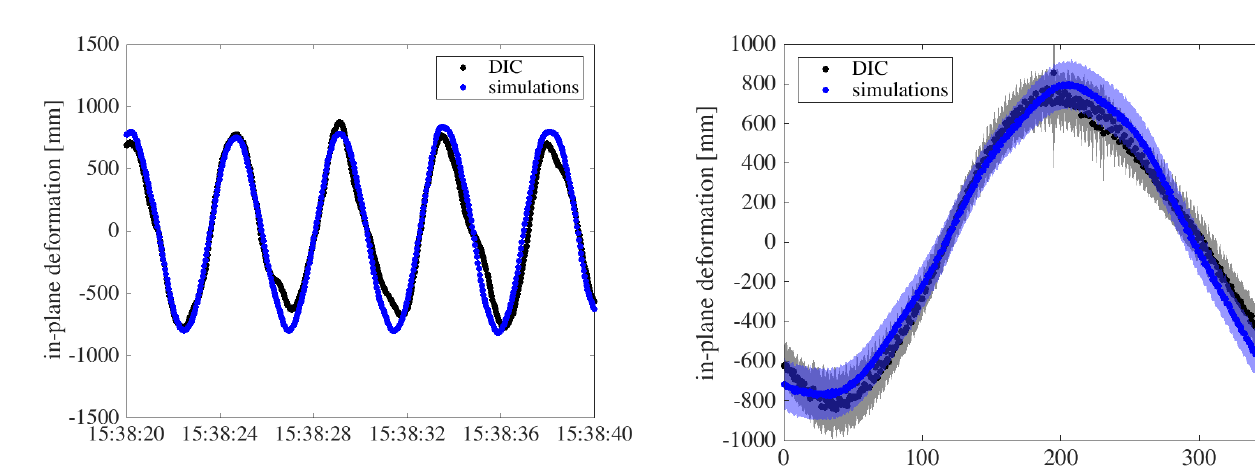
Figure 20. Comparison of IP deformation measurement and simu- lations of blade B – short time series.